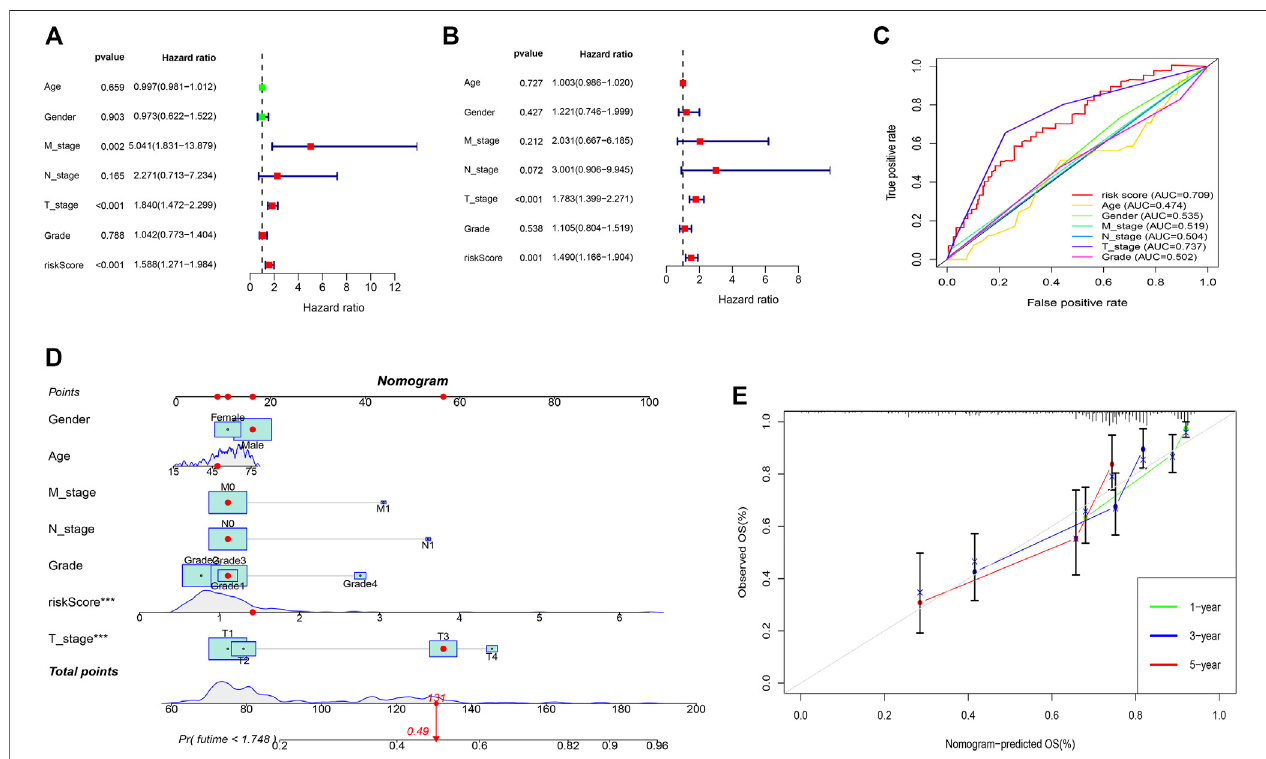
FIGURE 4 | Predictive nomogram. (A) Univariate analysis of the clinicopathologic features and the risk score. (B) Multivariate analysis of the clinicopathologic features and the risk score. (C) ROC curve of the clinicopathologic features and risk score. (D) Nomogram to predict the survival of the HCC patients. (E) Calibration curve for 1-, 3-, and 5-year